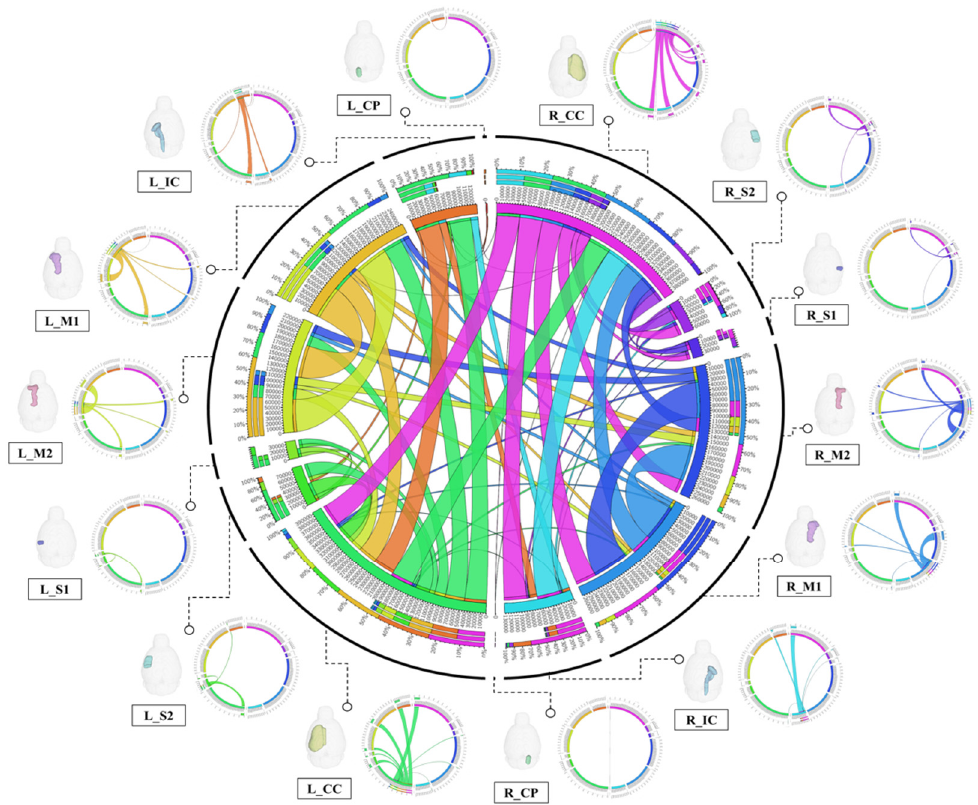
Figure 5. Connection diagram showing the structural connectivity of the consensus among the 14 structural domains. The structural regions of each cluster are represented by rectangles around a large circle, and the lines connecting the rectangles indicate the connections between the corresponding structural regions. The thicker the line, the higher the connectivity, and the thinner the line, the lower the connectivity. The center circle is expressed as the sum of the strengths of the connections between all structural regions, and the diagrams from each structural region (seed) to the other structural regions (target) are expressed around the circle. Each seed area was 3D rendered to represent the exact location, and lines from the specified area to all targets were individually rendered.Abbreviations: Primary motor cortex, M1; Secondary Motor Cortex, M2; Primary Somatosensory Cortex, S1; Secondary Somatosensory Cortex, S2; Corpus Callosum and Associated Subcortical White Matter, Corpus Callosum and Associated Subcortical White Matter, CC; Internal Capsule, IC; Cerebral Peduncle, CP; Left, L; Right, R.